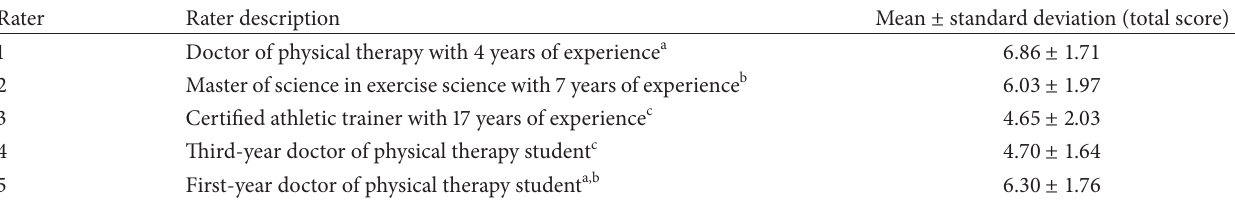
Table 1: Mean TJA total score by rater.